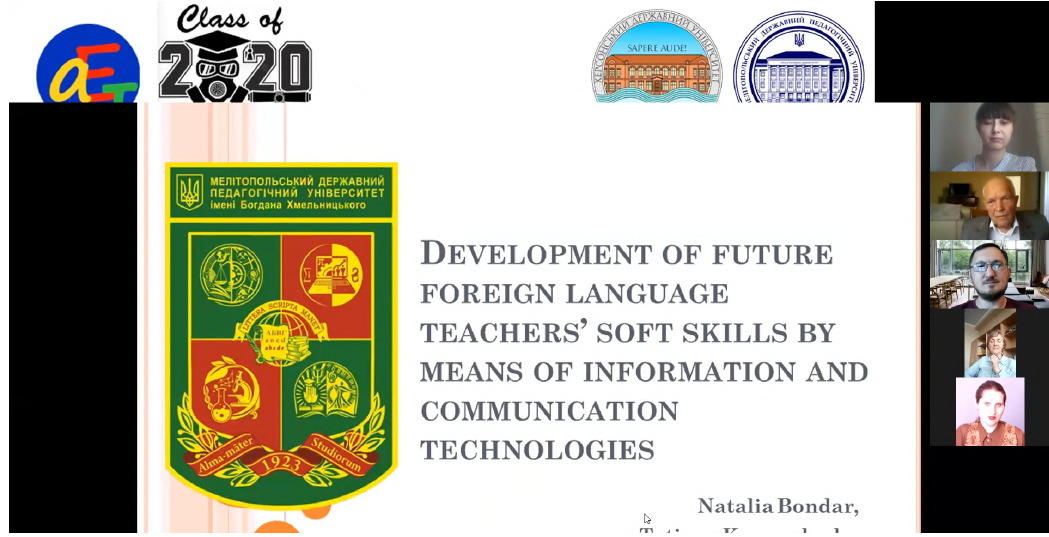
Figure 91: Presentation of paper [30].